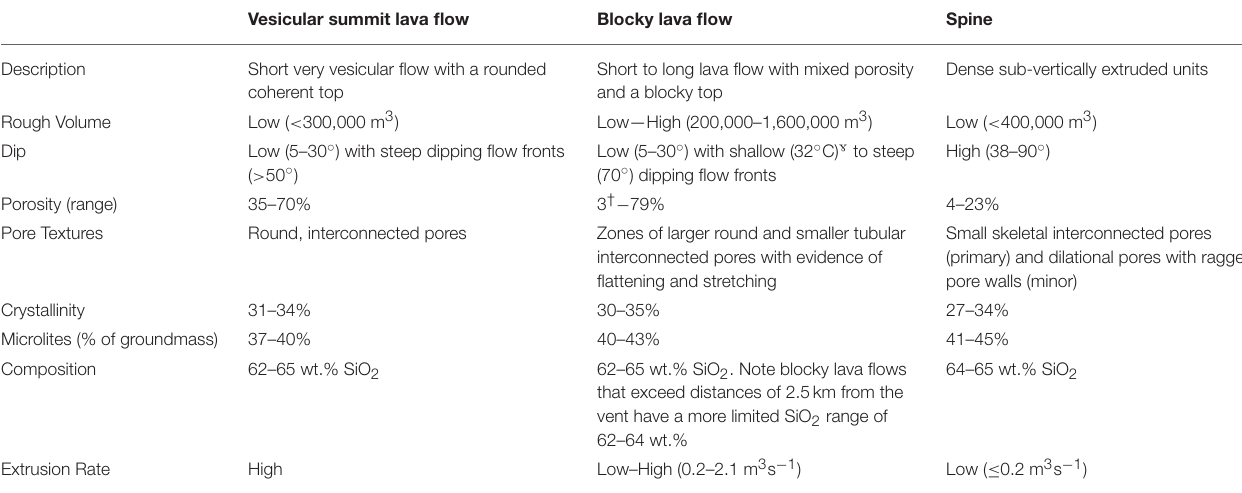
TABLE 1 | Summary of lava properties by